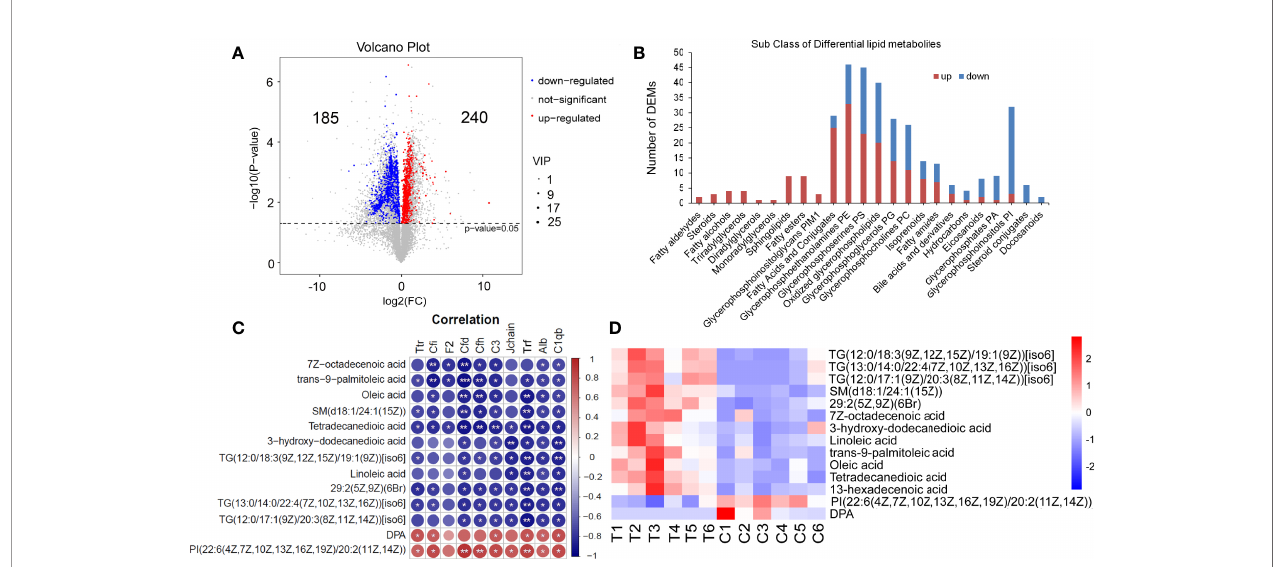
FIGURE 7 | Serum lipid metabolomics analysis and the correlation with proteomics. (A) The Volcano plot of 325 lipid DEMs (Lipidmaps Database), including 240 upregulated ones and 185 downregulated ones. (B) The classi fi cation of LC-MS lipid DEMs (Lipidmaps Database). (C, D) 13 DEMs that were signi fi cantly correlative with Alb and C1qb. T, thyrotoxicosis mice; C, normal control mice. Red is positive correlation and blue is negative correlation, correlation signi fi cance: * p <0.05; ** p <0.01; *** p